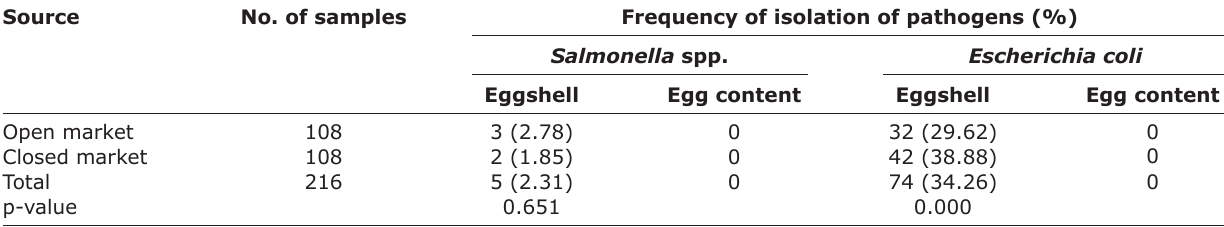
Table-1: Distribution of Salmonella and Escherichia coli based on source. Source